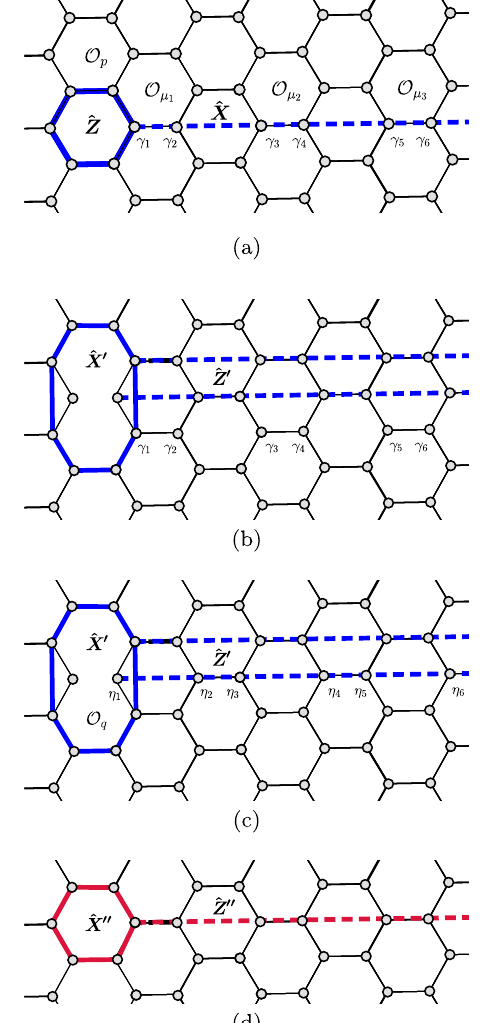
FIG. 10. Hadamard gate . A logical Hadamard is performed by transferring a qubit between distinct sublattices so that the logical ˆ X ˆ Z and operators are exchanged. We do this by taking the qubit ˆ X in (a) and multiplying the logical by the plaquette operators ˆ O ˆ O ˆ Z by and ceasing measurement of the f g and the logical μ p k fermion parity of plaquette p , yielding the operators shown in (b). Next, we measure the product ð i η 1 η 2 Þð i η 3 η 4 Þ … and ˆ Z 0 ˆ X 0 multiply by and , respectively. The final result is shown in